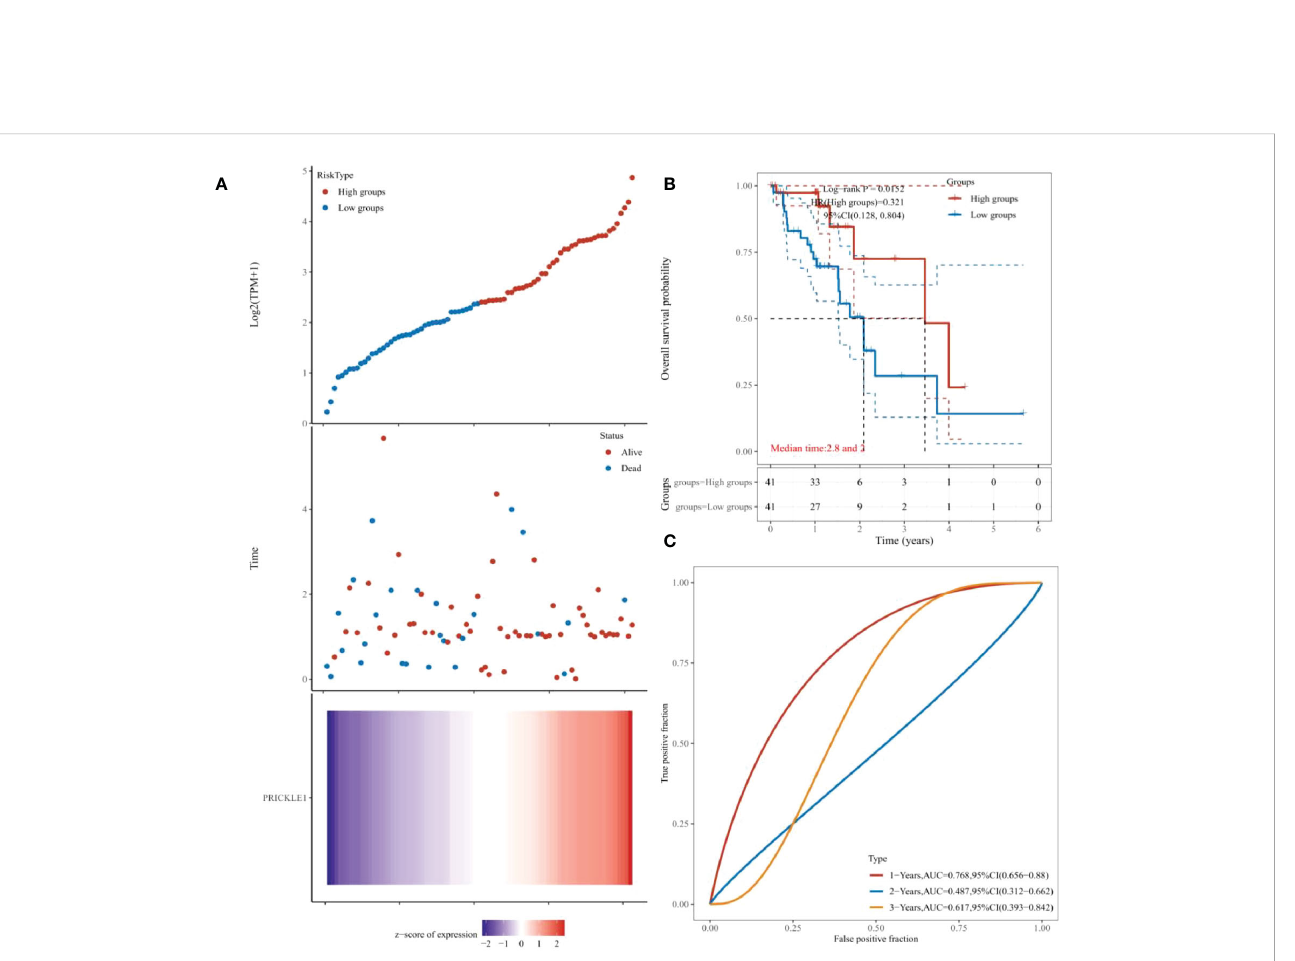
FIGURE 4 Single-gene prognostic analysis (A) Grouping according to individual gene expression; (B) Kaplan-Meier survival curves showing patient survival; (C) ROC showing the predictive performance of PRICKLE1 on patient survival at 1, 2, and 3 years.